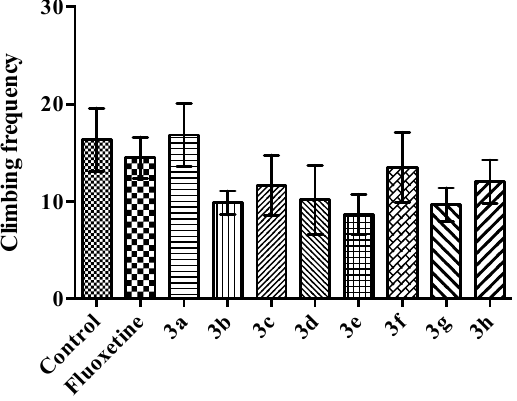
Figure 4. The effects of the test compounds 3a – 3h (40 mg/kg) and fluoxetine (20 mg/kg) on the climbing frequencies of the mice in MFST. Values are given as mean ± SEM, ( n = 6).